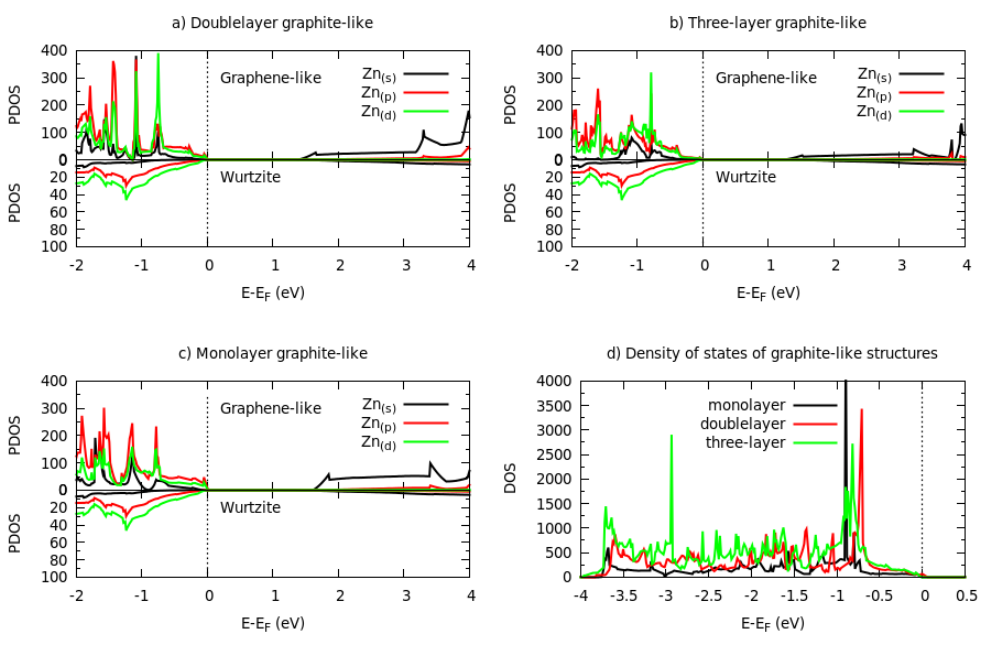
Figure 5: PDOS of the zinc within the structure of graphene-like forms (top-half) and wurtzite (lower-half). The black, red and green lines represent the sublevels. The DOS of graphene-like structures is shown below on the